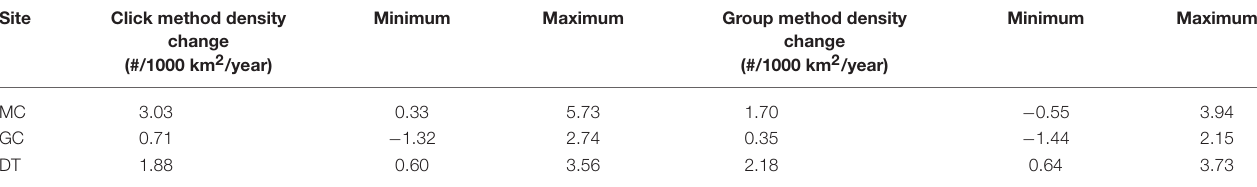
TABLE 6 | Annual trends in Kogia spp. density by site and method (column 2 = click method and column 5 = group method).